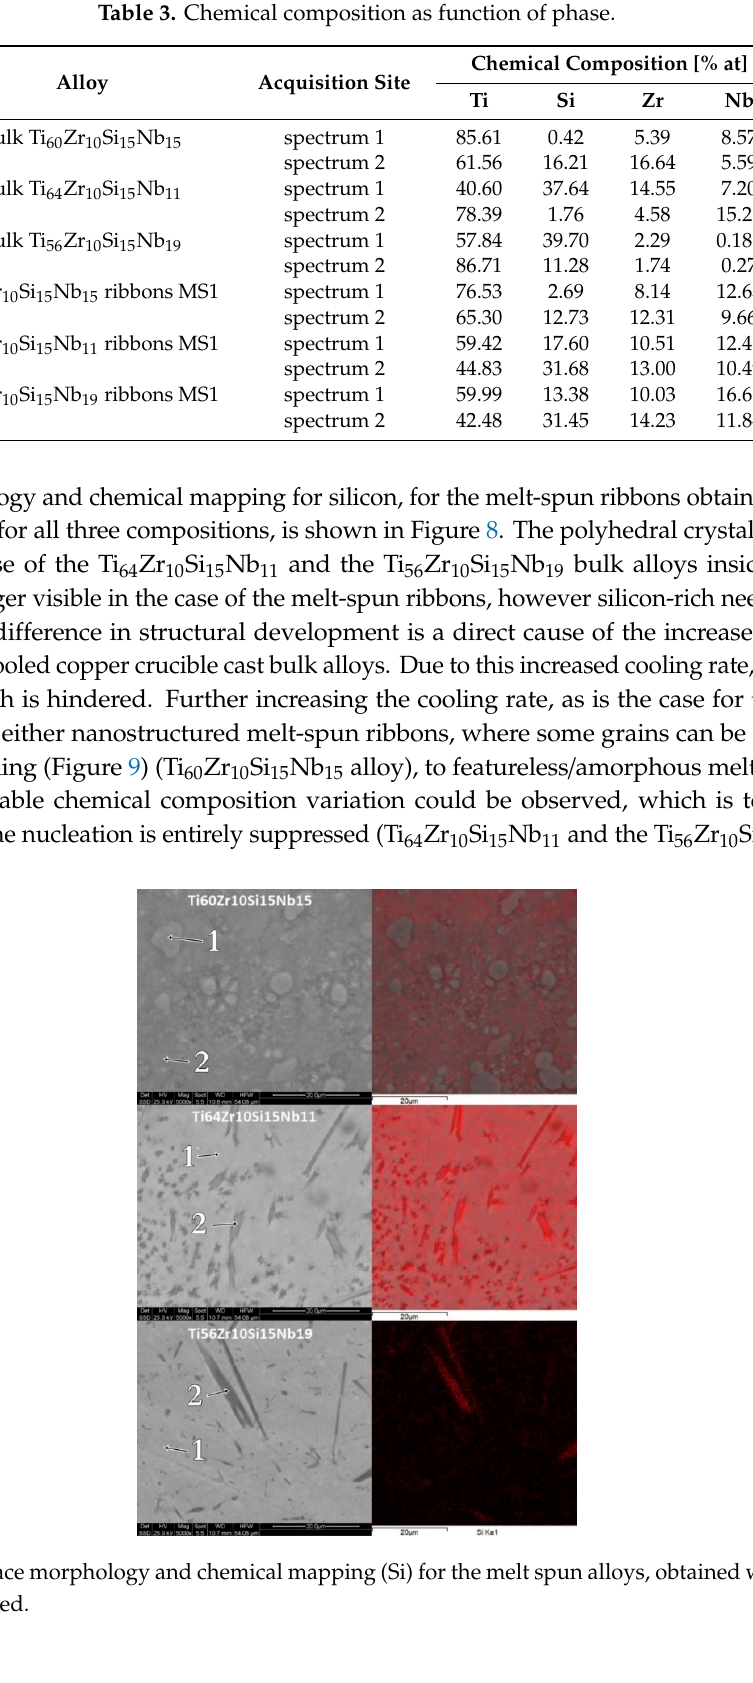
Table 3. Chemical composition as function of phase.